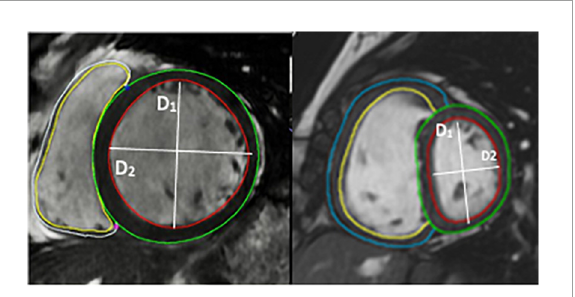
FIGURE3 Image of short axis CMR demonstrating the volumetric analysis and the calculation of eccentricity index using CMR